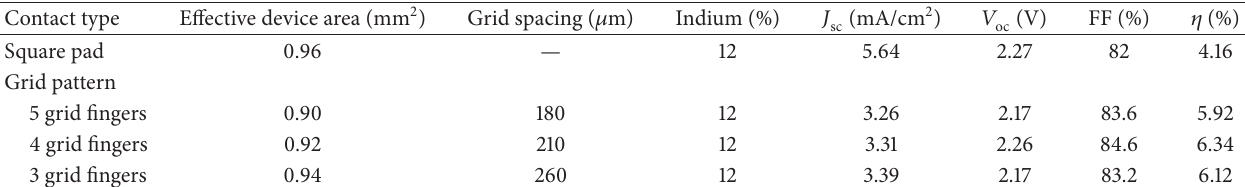
Table 2: Characteristic parameters of simulated InGaN p-i-n solar